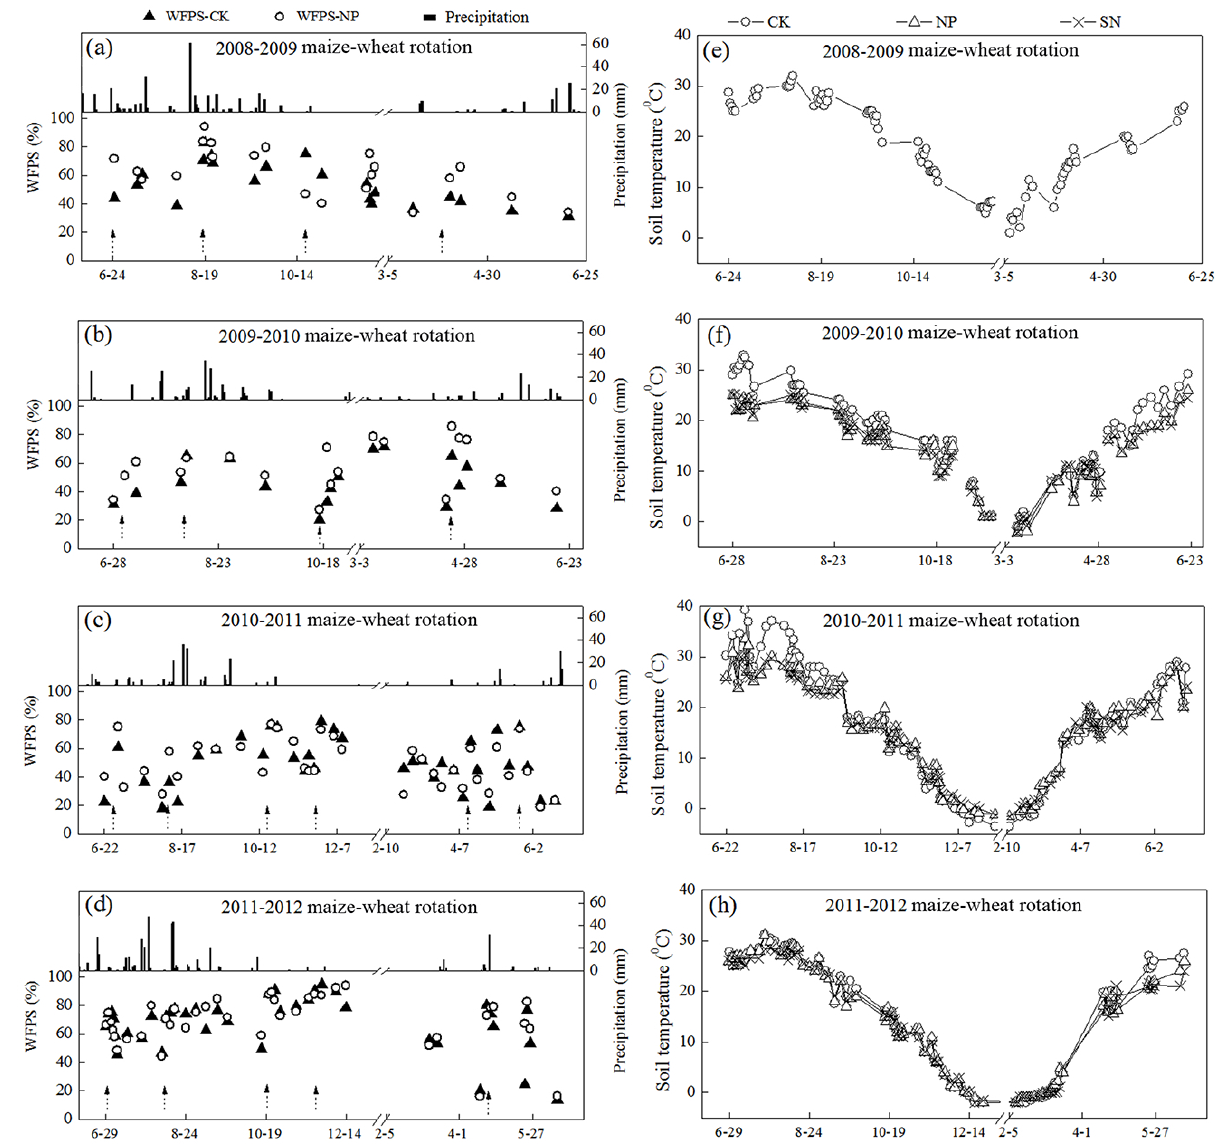
Fig. 1. Precipitation, soil WFPS (a, b, c, d) and soil temperatures (e, f, g, h) in the CK and NP treatments during 2008–2012 maize–wheat rotations. Dashed arrows show irrigation